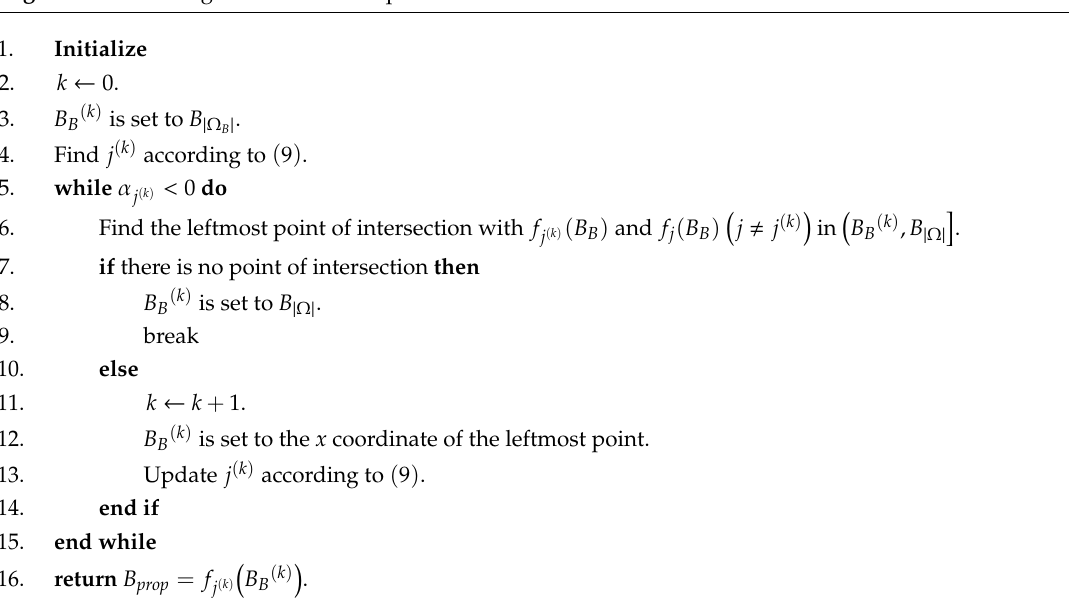
Algorithm 1 : Finding the minimum required